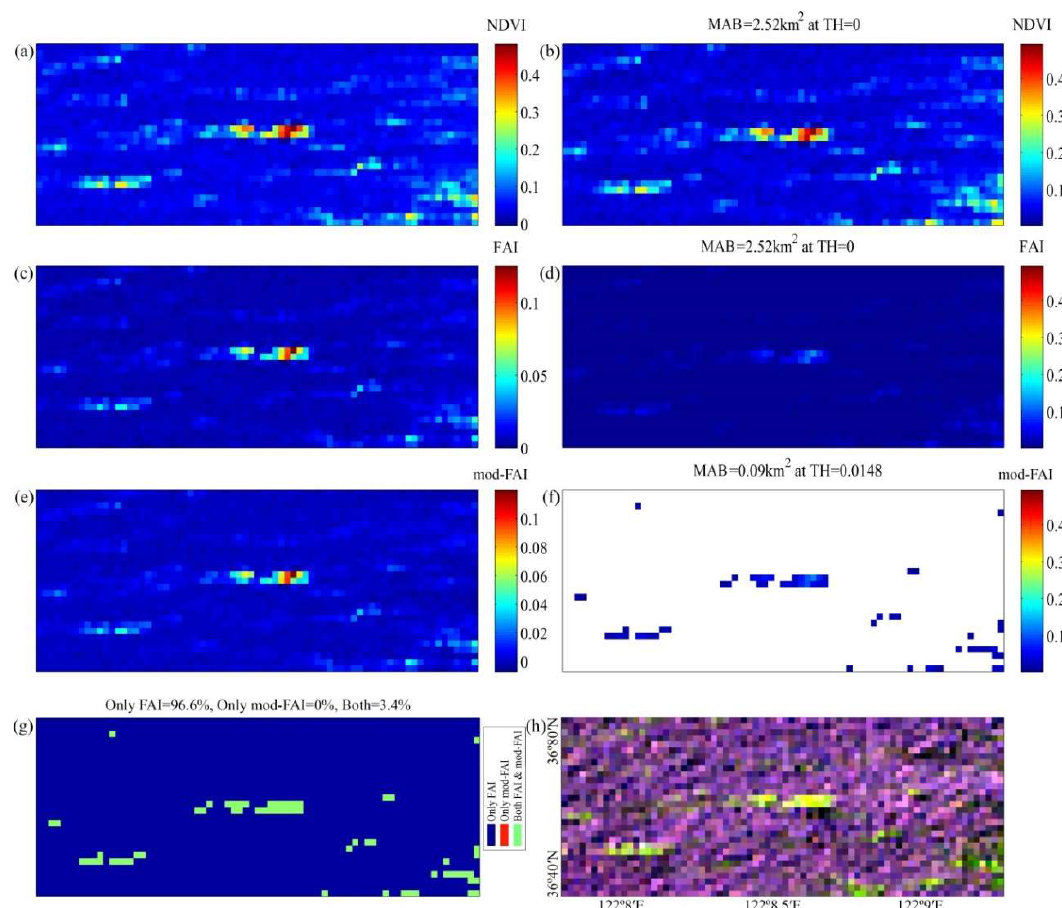
Figure 7. Comparison of Landsat-8 based vegetation indices colourmaps of ( a ) NDVI, ( c ) FAI, and ( e ) modified FAI with the thresholding-based detected macroalgae in the corresponding vegetation indices ( b , d , and f , respectively) for the small ROI area (Figure 1) of path/row 119/34 on 25 June 2016 at 02:29 UTC. The respective ( g ) common as well as only FAI and modified FAI-based detection, and ( h ) the natural colour composite image (Landsat bands 4, 3, and 2) are also compared.